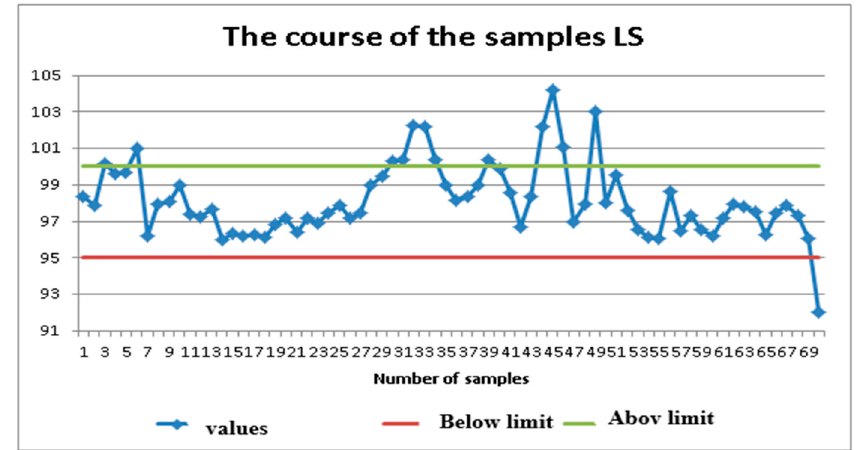
Figure 9. LS content in clinker with the limits. Source: own source.